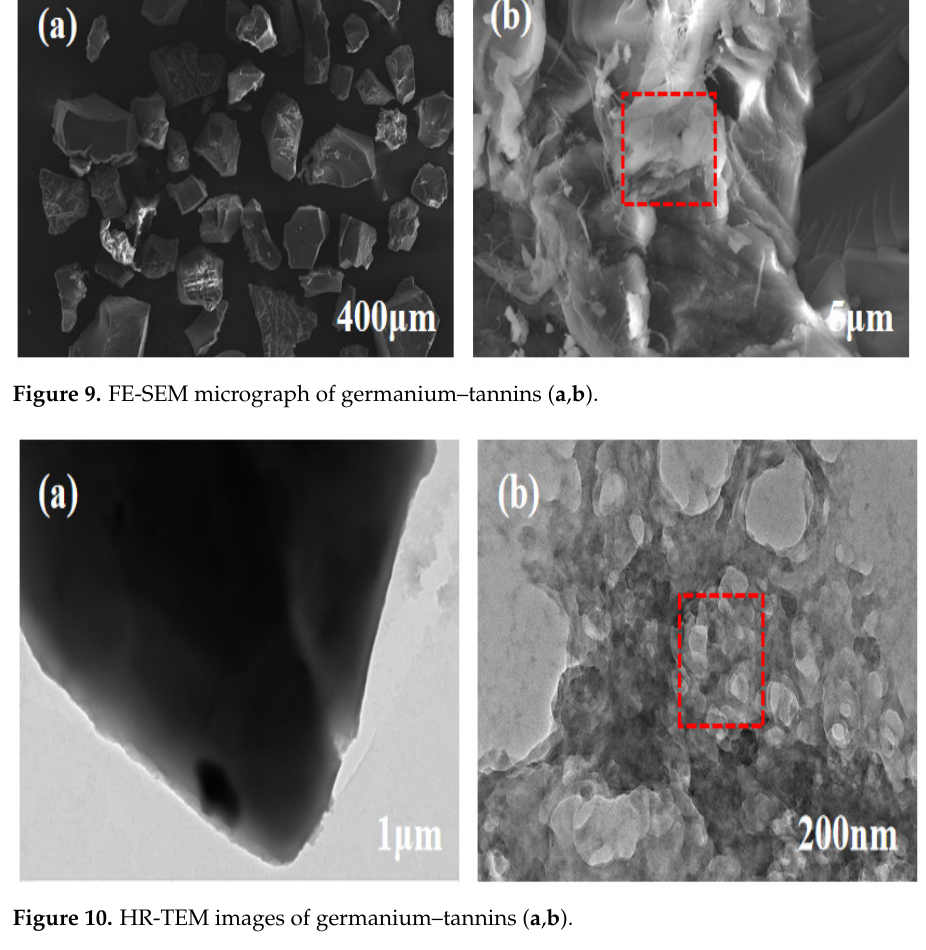
Figure 10. HR-TEM images of germanium–tannins ( a , b Figure 10. HR − TEM images of germanium–tannins ( a , b ).